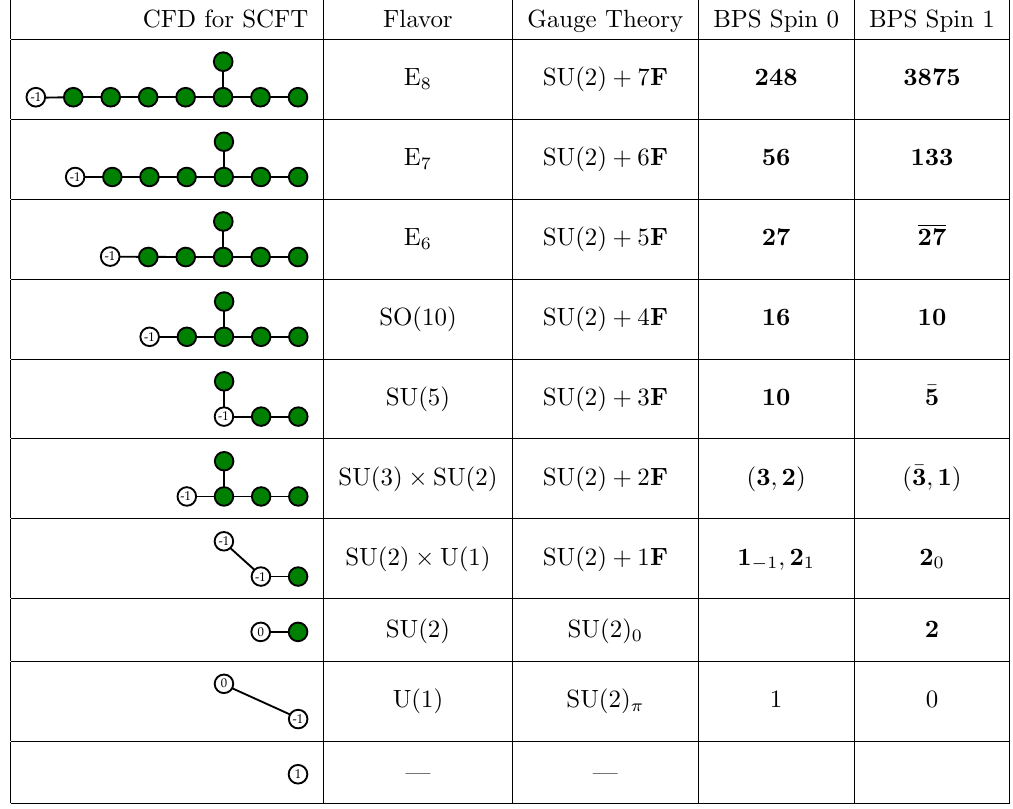
Table 4 . All 5d rank one SCFTs and the lowest spin BPS states from M2-brane wrapping modes over genus zero curves. We also list their (cid:13)avor symmetry, gauge theory